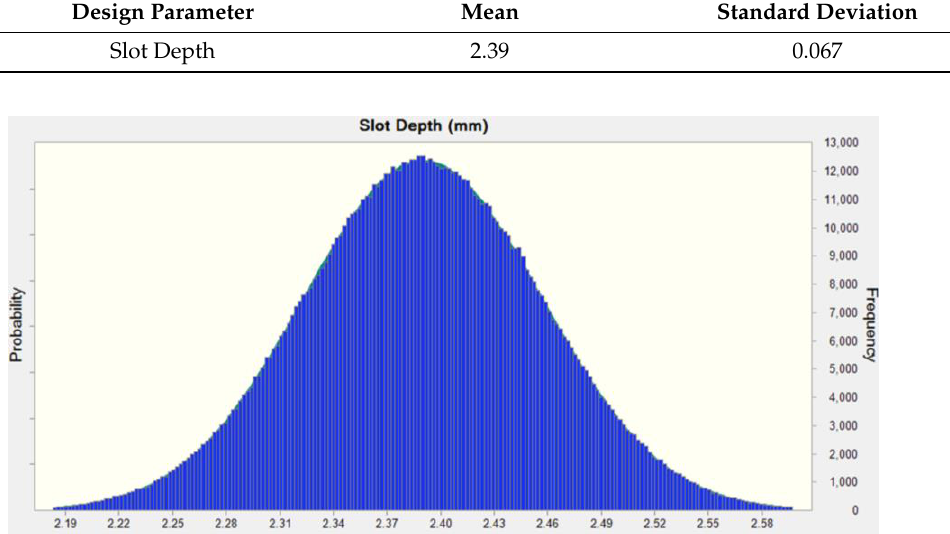
Figure 19. Performance distribution of probability normal distribution for OASPL. 4. Conclusions In this study, a design process for developing a high-torque and low-noise BLDC motor was developed and verified. The effectiveness and noise characteristics of the mo- tor were analyzed through design parameter analysis, and the low-noise structure of the motor was optimized. Design parameters were selected through a partial factorial design and optimized through response surface design. In addition, the optimal design of the design parameter tolerances was performed using the statistical method and Monte Carlo analysis. It is expected that the proposed process will contribute to robust design in the design stage for noise issues, and the conclusions are summarized as follows: